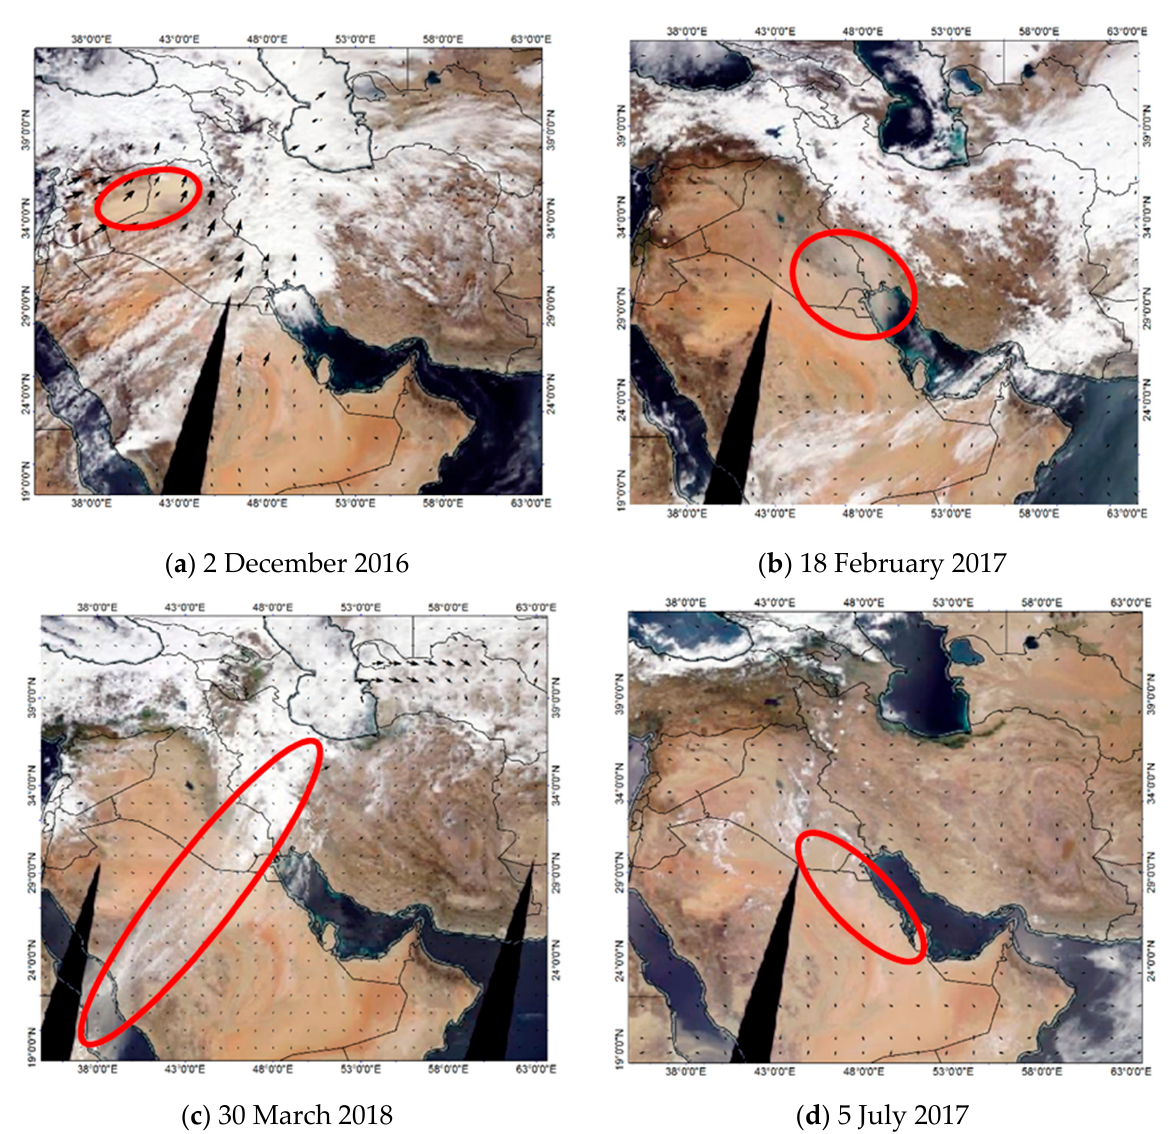
Figure 1. Terra-MODIS true color images and wind vectors at 850 hPa on ( a ) 2 December 2016 (cyclonic dust storm), ( b ) 18 February 2017 (post-frontal dust storm), ( c ) 30 March 2018 (pre-frontal dust storm), ( d ) 5 July 2017 (Shamal dust storm). The overlaid wind vectors were taken from ERA-Interim reanalysis, while the red ovals show the position of the dust plumes.